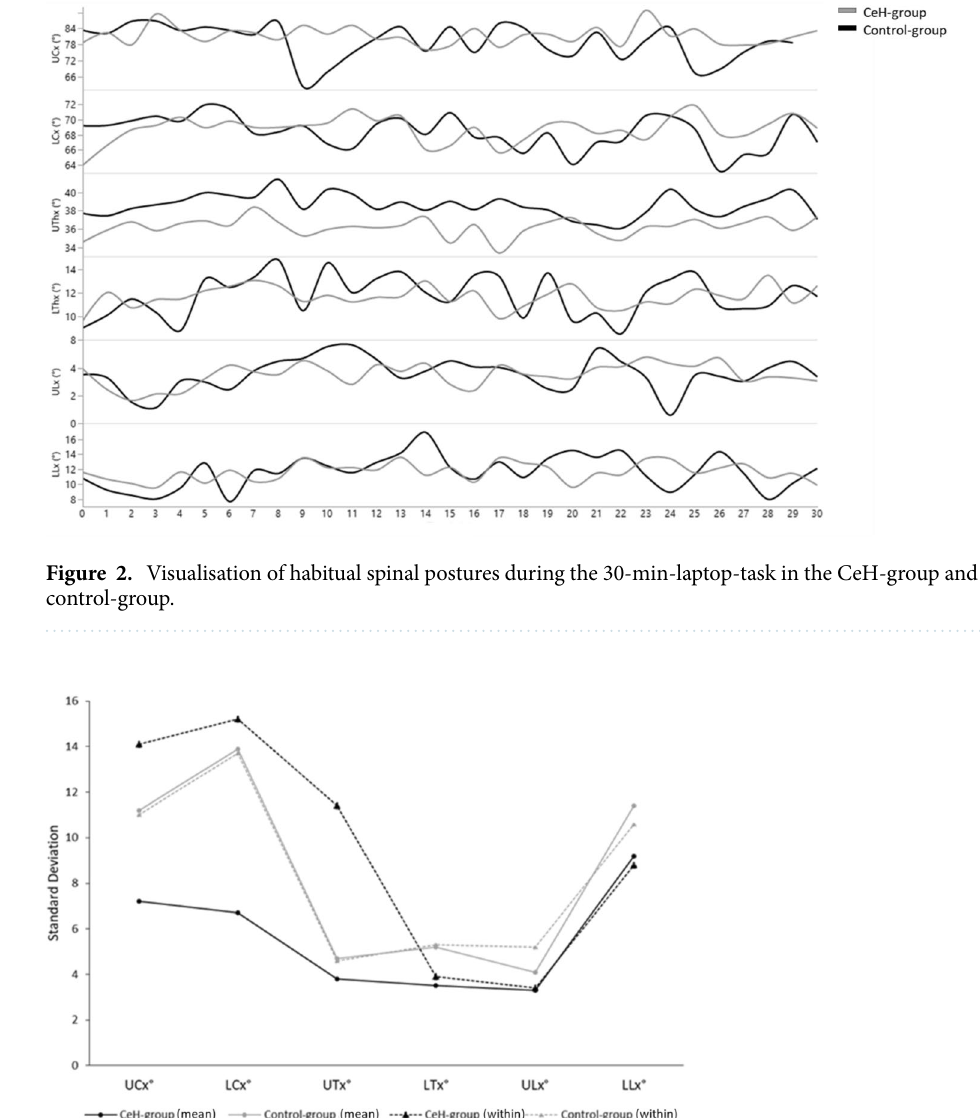
Figure 3 . Visualization of the mean and within-group SPV in the CeH-group and control-group expressed through the